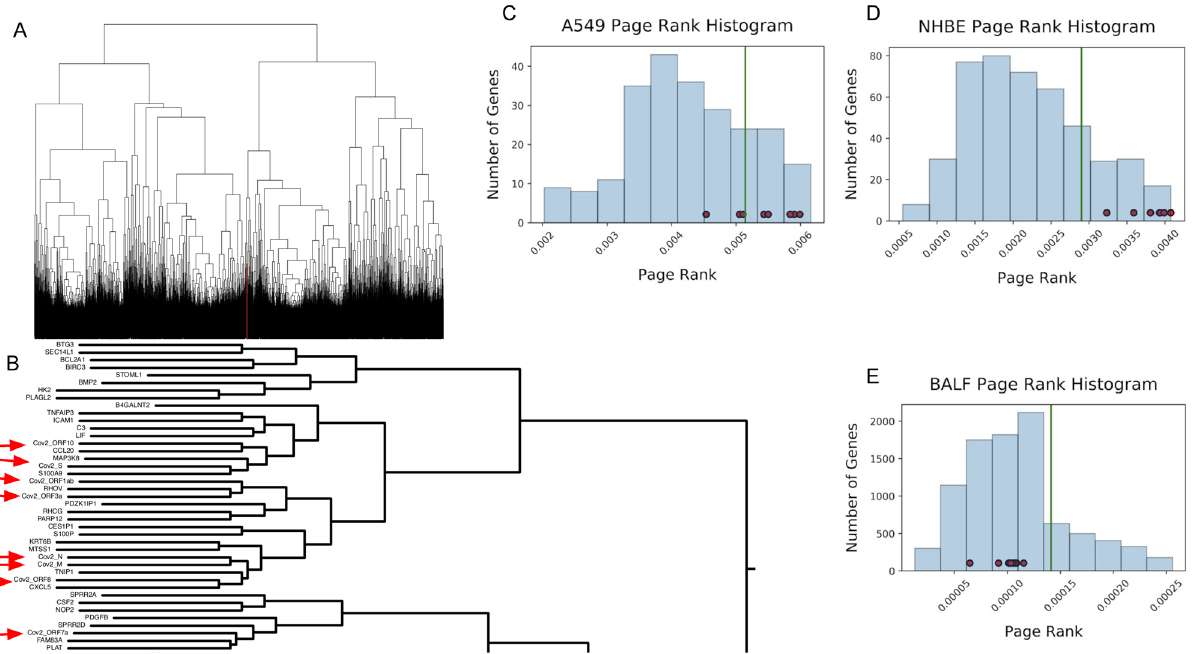
Figure 3. By clustering expression SARS-CoV-2 and human expression patterns concurrently we observed that SARS-CoV-2 transcripts were localized in a small clade visualized in red ( A ). This clade of coexpression with SARS-CoV-2 transcripts contains a set of genes associated with SARS-CoV-2 mechanisms in infection ( B ). The histogram distribution of PageRank values for the A549 ( C ) and NHBE ( D ) cell lines shows that the SARS- CoV-2 genes are highly influential. However, in BALF samples ( E ), SARS-CoV-2 genes are at the lower end of the PageRank distribution likely due to the numerous differentially expressed genes creating a much larger set than that for the cell lines. In A-C, the green line marks the 80th percentile in the distribution and the small red nodes along the distribution represent SARS-CoV-2